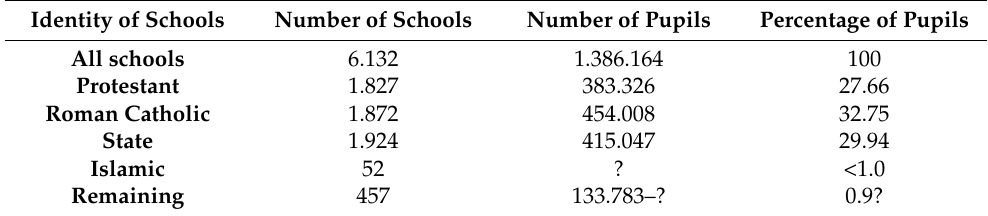
Table 1. Schools and pupils according to primary school identity 6 . Identity of